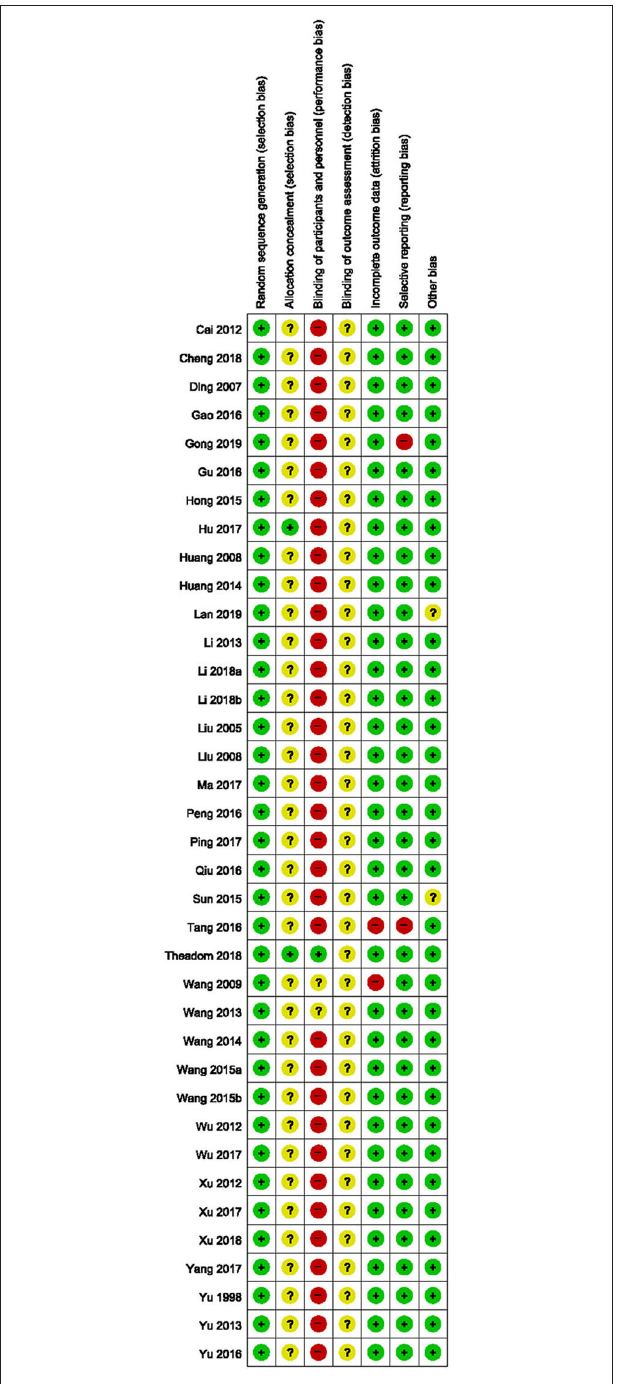
FIGURE 2 | Risk of bias summary for all included studies. Low, unclear, and high risk, respectively, are represented with the following symbols: “ + ”, “?”, and